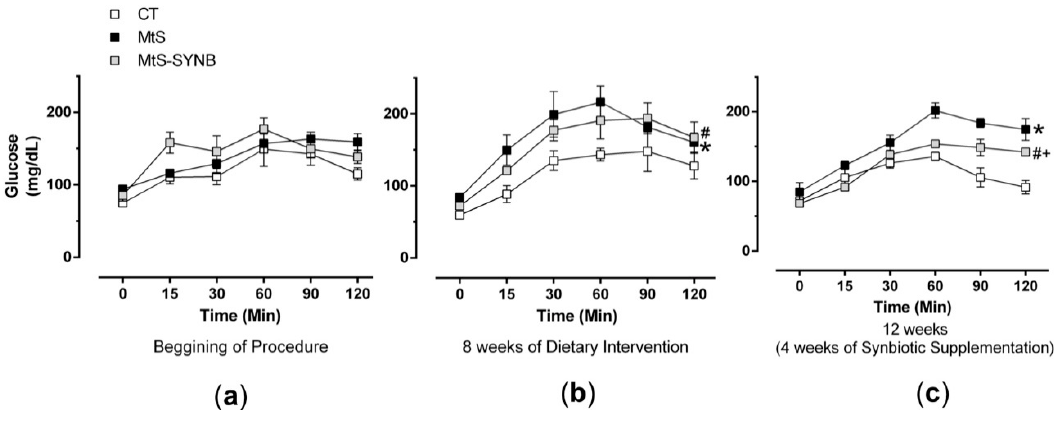
Figure 4. Evolution of insulin resistance measured by glucose tolerance test in CT, MtS and MtS-SYNB rats at the beginning of procedure ( a ), after 8 weeks of diet intervention ( b ) and after 12 weeks once the synbiotic supplementation terminated ( c ). Results are expressed as mg glucose / dL (mean ± S.E.M). Statistical analysis: Unpaired two-way ANOVA. * p < 0.05 CT vs. MtS; # p < 0.05 MtS vs. MtS-SYNB; + p < 0.05 CT vs. MtS-SYNB.